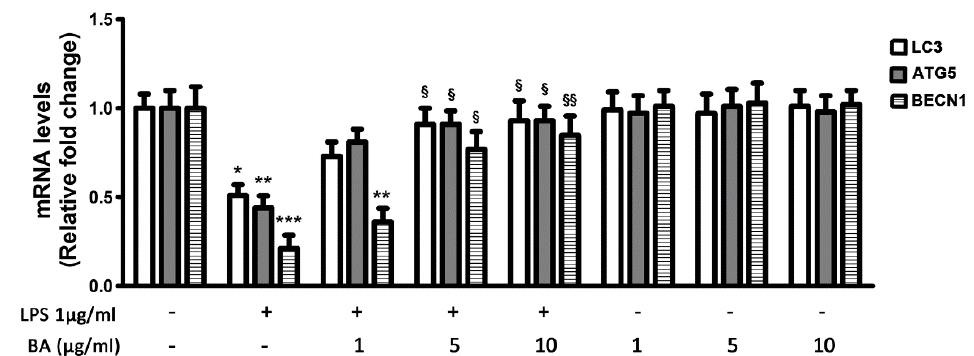
Figure 3. Effects of BA on LC3, ATG5 and BECN1 gene expression in HT-29 cells stimulated with LPS. HT-29 cells were treated with BA that was added to culture medium 30 min before exposure to LPS for 4 h. The mRNA transcript levels were analyzed by Real-Time PCR. * p < 0.05, ** p < 0.01, *** p < 0.001, significant differences vs. Ctr; § p < 0.05, §§ p < 0.01, significant differences vs. LPS-treated cells.